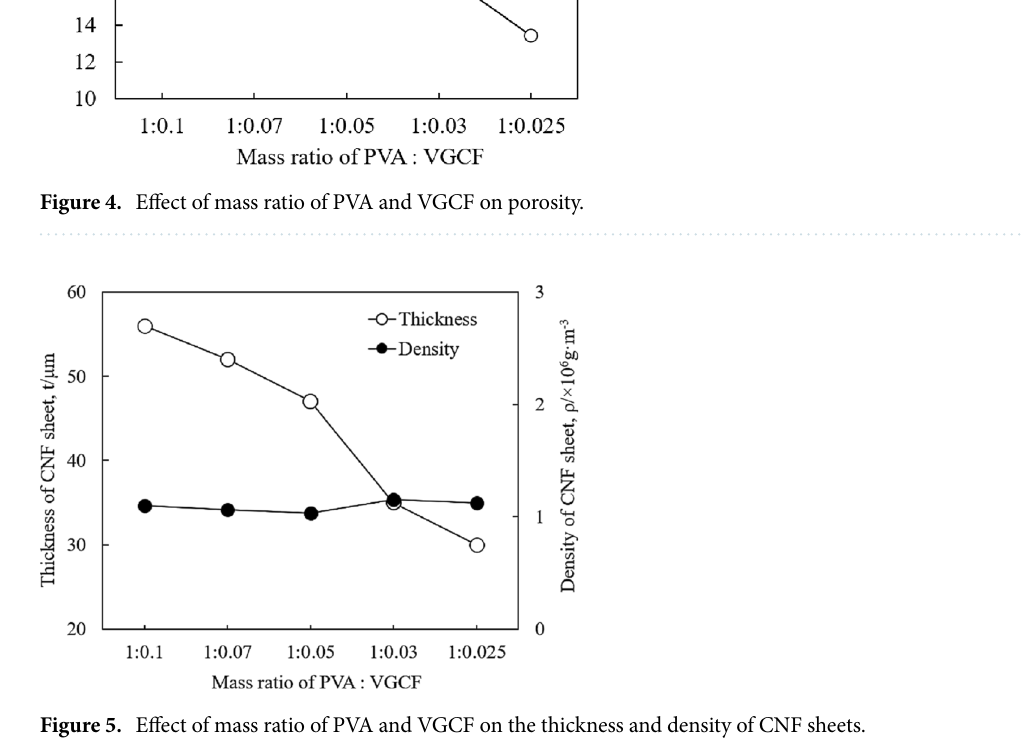
Figure 5. Effect of mass ratio of PVA and VGCF on the thickness and density of CNF